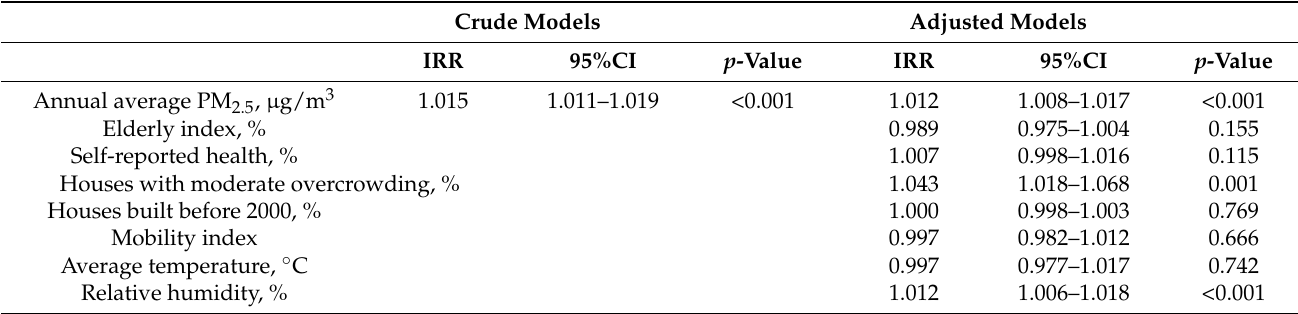
Table 2. Crude and adjusted association between COVID-19 incidence rate and PM 2.5 and PM 10 in 188 Chilean communes in